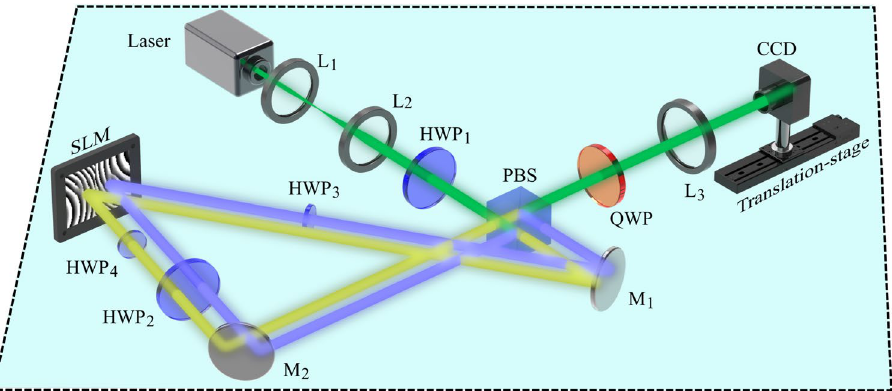
Figure 5. Schematic representation of the optical setup implemented to generate CAVV mode. L 1 -L 3 : lenses, HWP 1 -HWP 4 : Half-Wave plate, QWP: Quarter-Wave Plate, PBS: Polarizing Beam Splitter, M 1 -M 2 : Mirror, SLM: Spatial Light Modulator, CCD: Charged Device